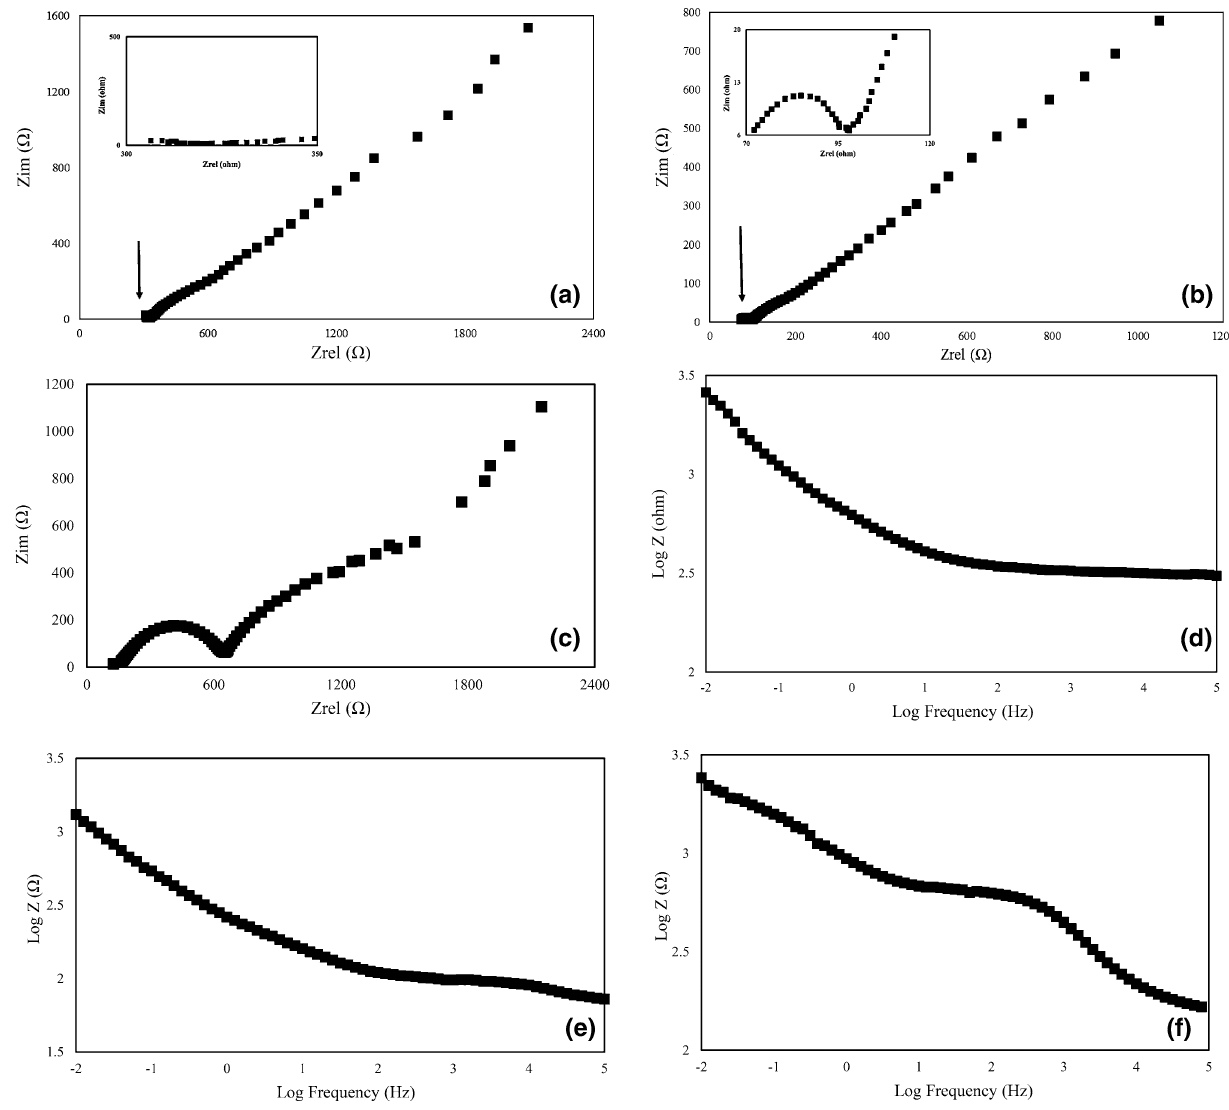
Fig. 10 The Nyquist curves of the paper supercapacitors based on a PVDF gel electrolyte, b PVA gel separator, c BaTiO Bode curves of the paper supercapacitors based on d PVDF gel electrolyte, e PVA gel separator, f BaTiO 3 gel